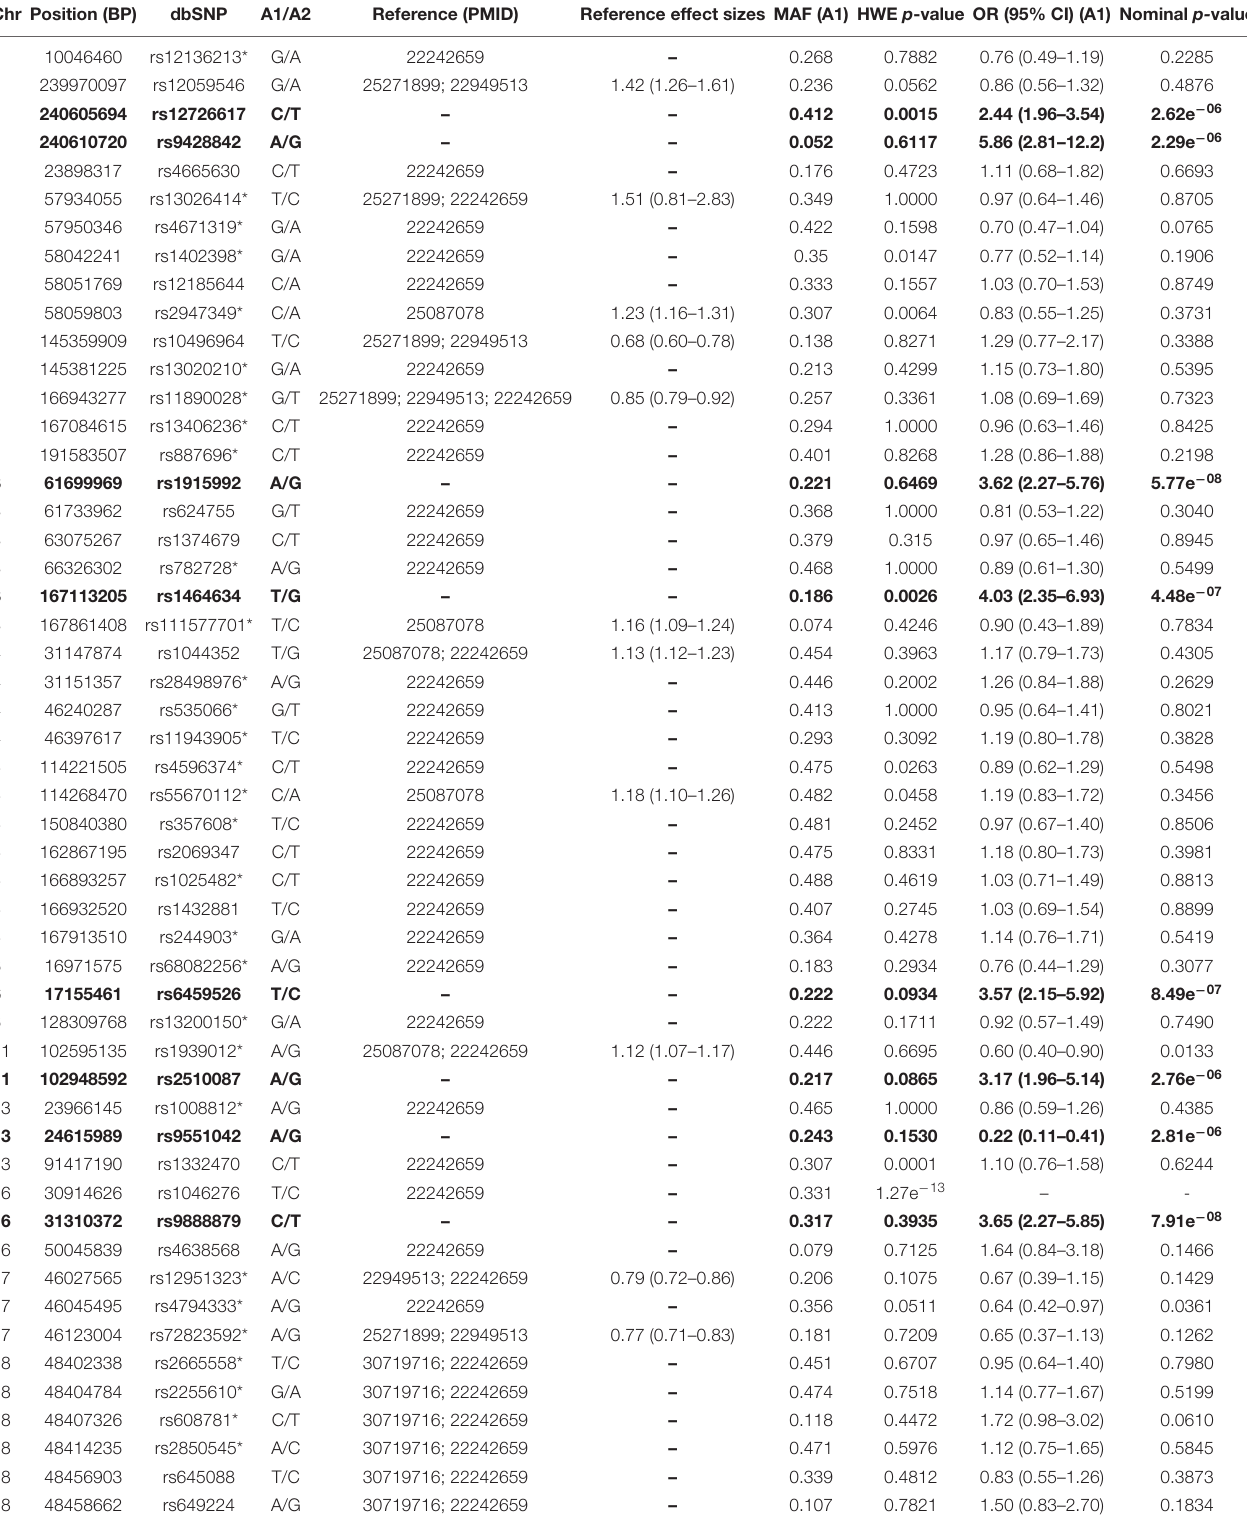
TABLE 1 | Descriptive statistics and logistic regression analysis of the candidate SNPs and the nine flanking SNPs that passed the most stringent Bonferroni correction ( p -value = 3.55e − 06 ; in bold). Chr Position (BP) dbSNP